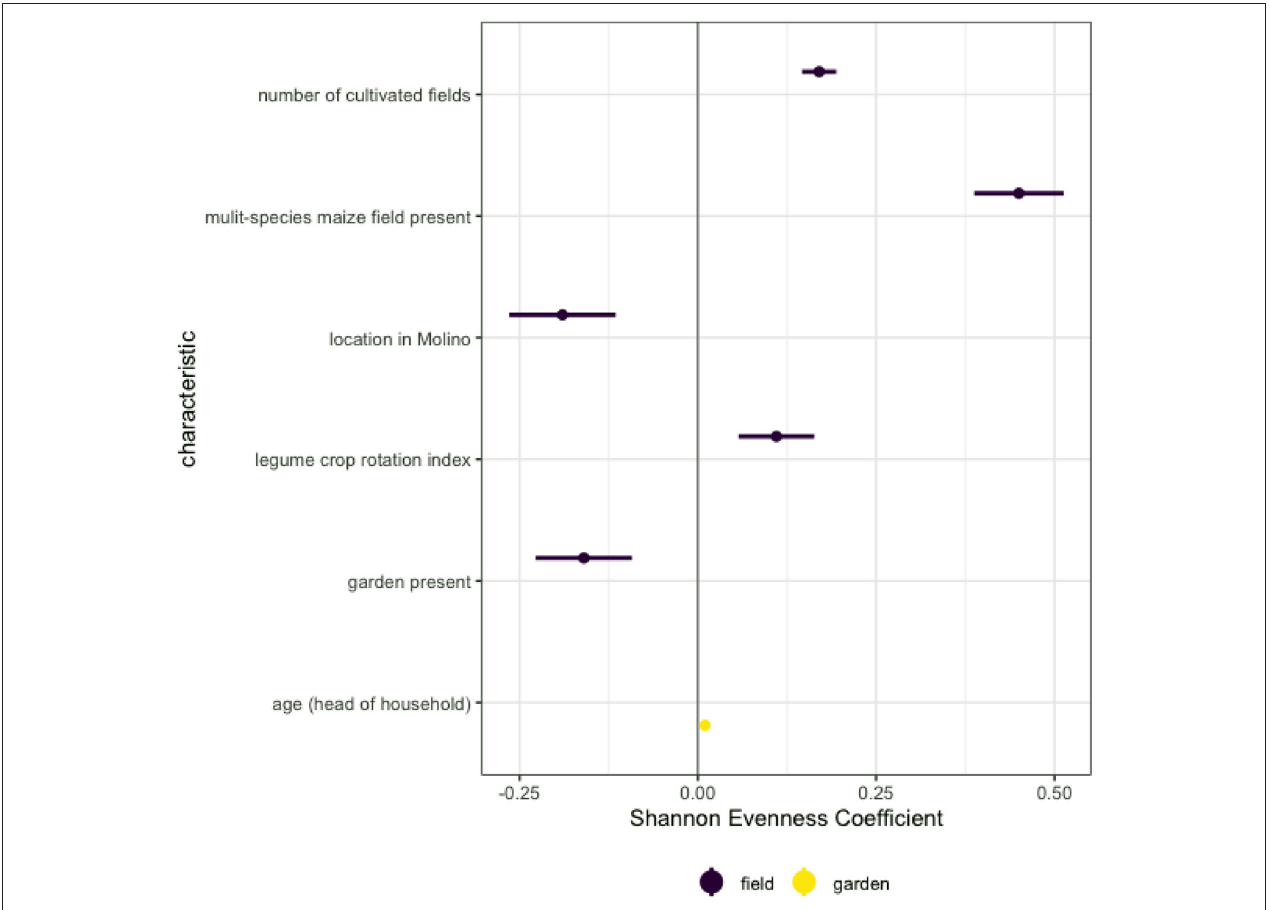
FIGURE 7 | Coefficients and standard errors in regression results on factors in ordinary least squares regression models for Shannon evenness in agrobiodiversity-and-food spaces (field, garden; each color represents an individual regression